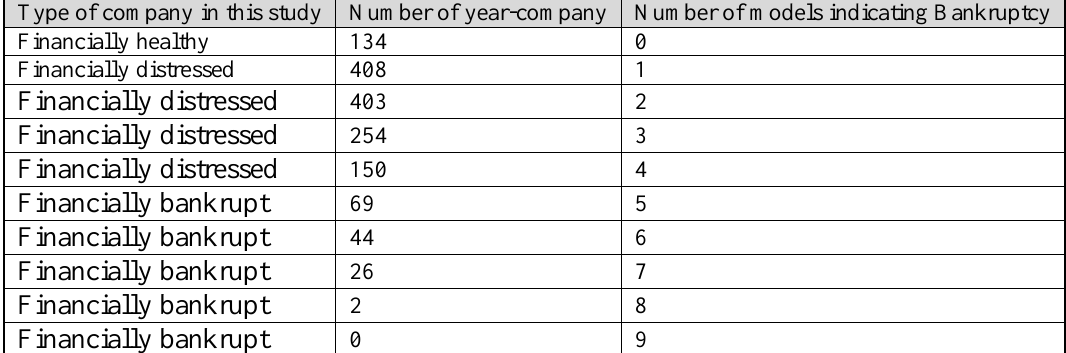
Table 3: The number of companies and the number of models indicating Bankruptcy